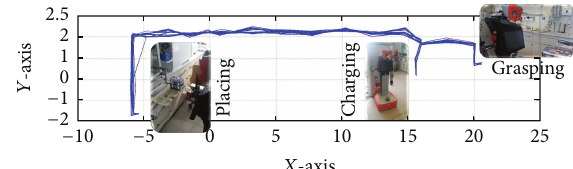
Figure 16: The real mobile robot transportation path on single floor.